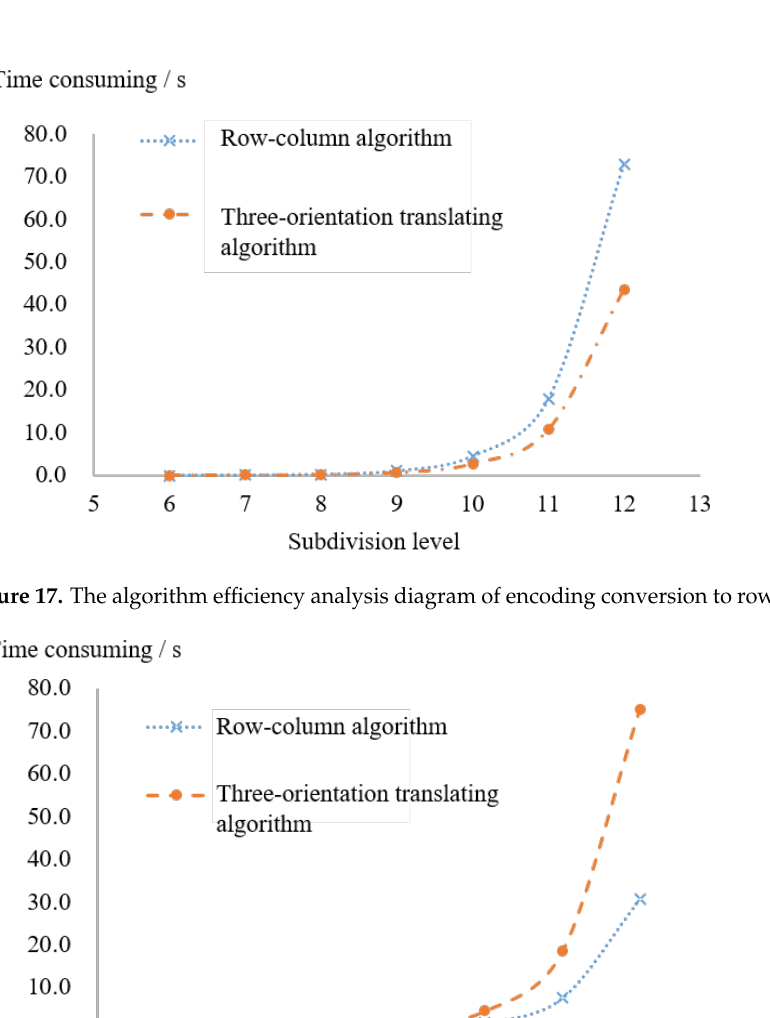
Figure 18. The algorithm efficiency analysis diagram of row–column number conversion to encod-